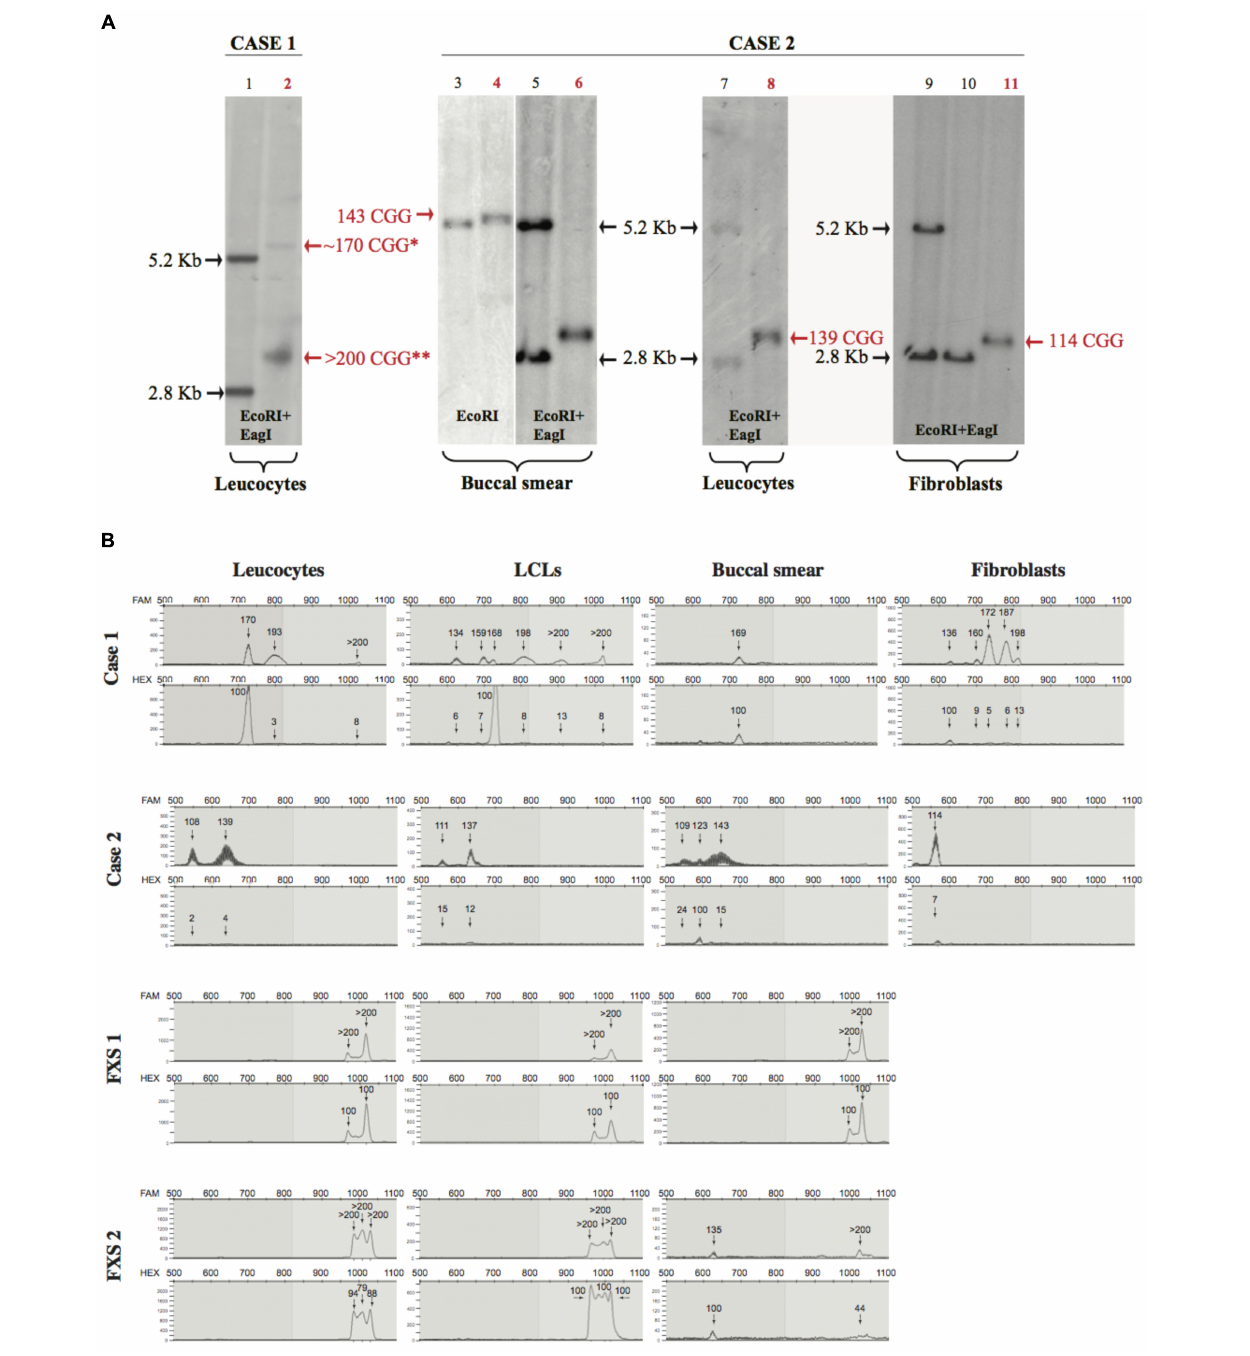
FIGURE 1 | Southern blot and mPCR analysis. (A) Southern blots of Case 1 and Case 2 (lane numbers for these samples are shown in red). Left panel (control in lane 1 and Case 1 in lane 2), analysis upon EcoRI-EagI DNA digestion from leucocytes. Right panels (controls in lanes 3, 5, 7, 9, 10 and Case 2 in lanes 4, 6, 8, 11) analysis upon EcoRI or EcoRI-EagI DNA digestion. Relative number of triplets is noted next to the bands; red text refers to number of triplets belonging to Case 1 and Case 2. ∗ is used to indicate a methylated premutation (lane 2), while two stars indicate the > 200 CGG unmethylated allele. It is notable that, in Case 1 (lane 2), the 170 premutation allele is methylated while the expansion over 200 CGG (full mutation) is unmethylated; in Case 2, the methylated premutation allele of 123 repeats it is not detectable by Southern blot (lane 6 buccal smear). (B) Electropherograms representing CGG repetition alleles (top panel) and methylation percentages (bottom panel) relative to different tissues for Case 1, Case 2, FXS 1, and FXS 2 samples.